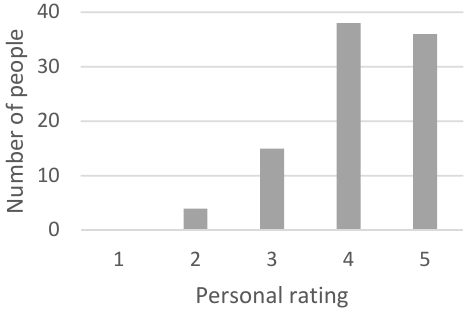
Figure A18. Perceived personal knowledge on recycling scheme in Borås, second survey (93 individuals). Question 4.